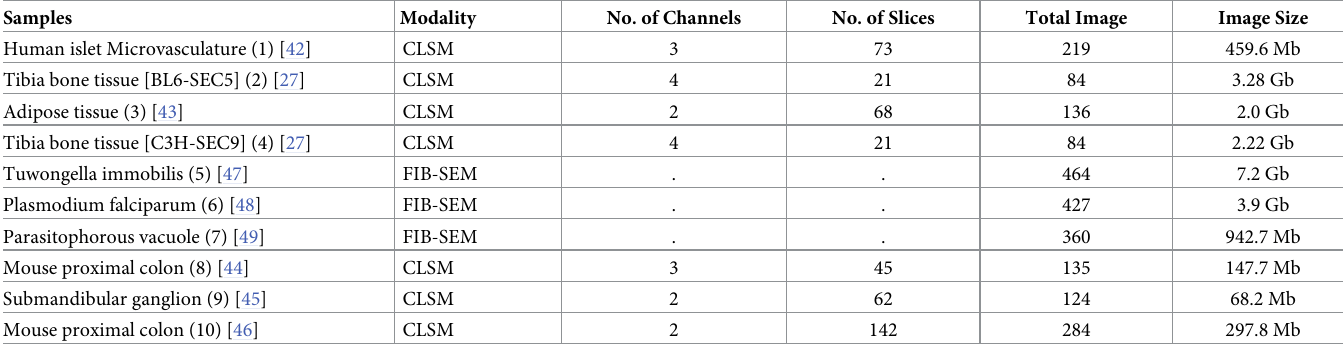
Table 1. Selected CLSM and FIB-SEM microscope images.